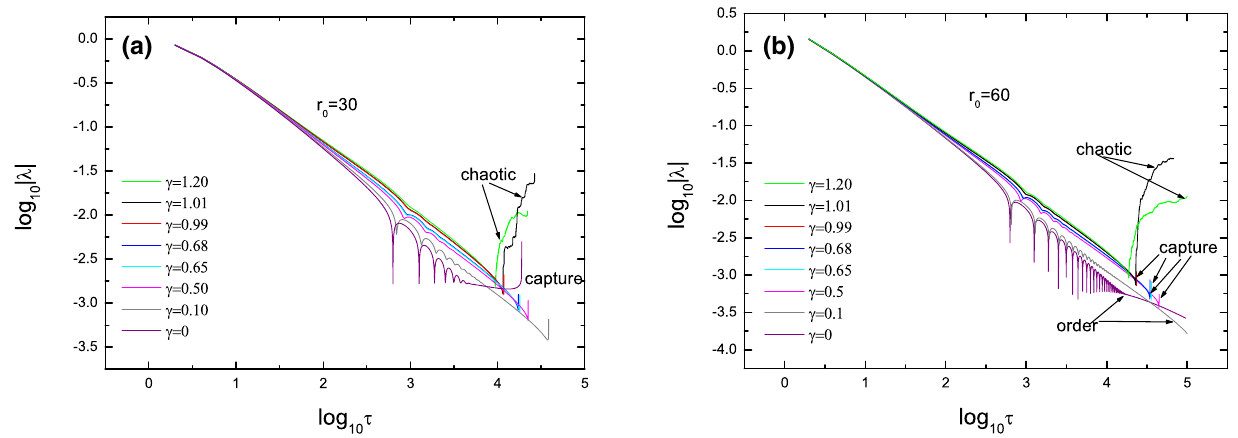
Fig. 6 The maximum Lyapunov exponents of the string trajectory for different γ with fixed r 0 (left pannel is for r 0 =30 and right pannel for r 0 = 60) Table 2 The dynamics behaviors of the string for different γ and r 0 . “O”, “C” and “ / C ” denote “Ordered”, “Chaotic and being captured” and “Chaotic but not being captured”, respectively. These results are